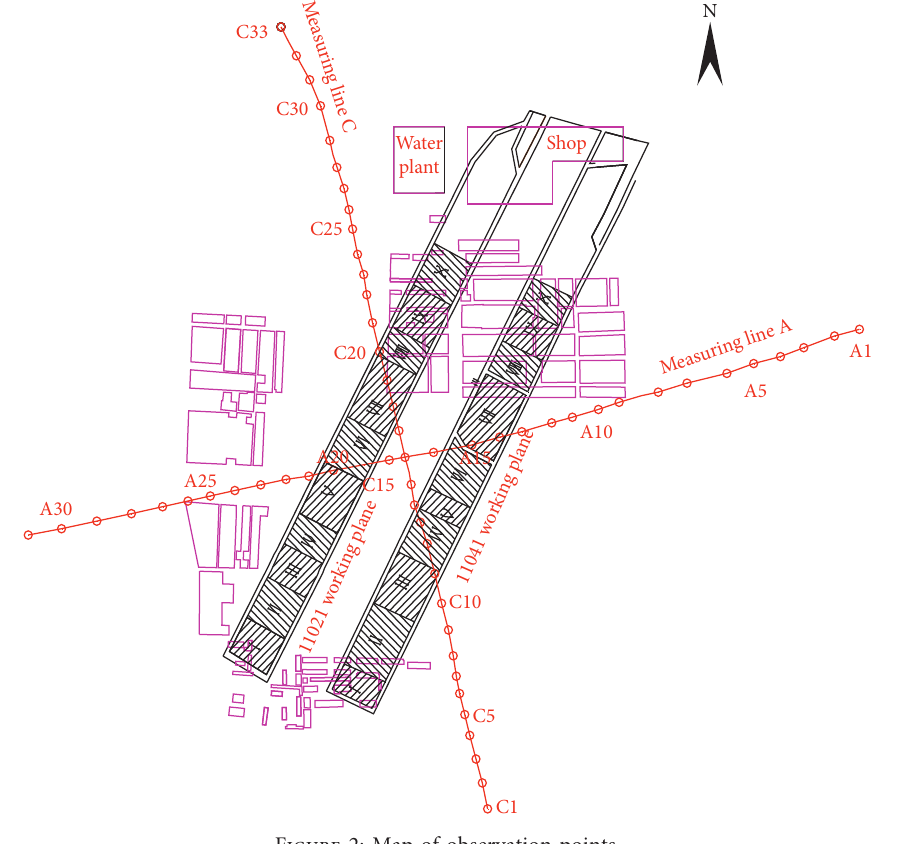
Figure 2: Map of observation points. Table 1: List of improved probability integral method